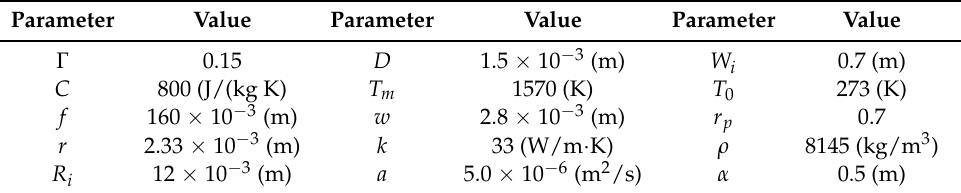
Table 4. Parameters values used for MPC controller testing.